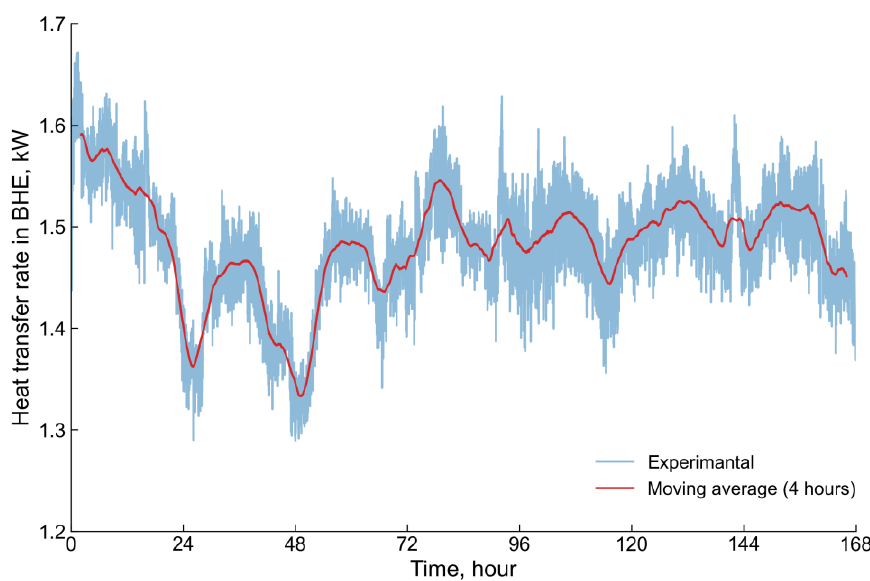
Figure 7. Energy performance of the BHE.